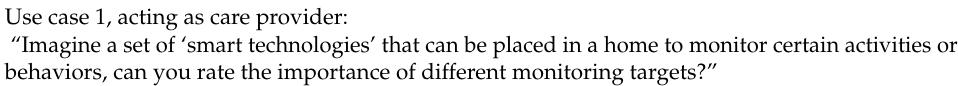
Table 1. Questions related to hypothetical use